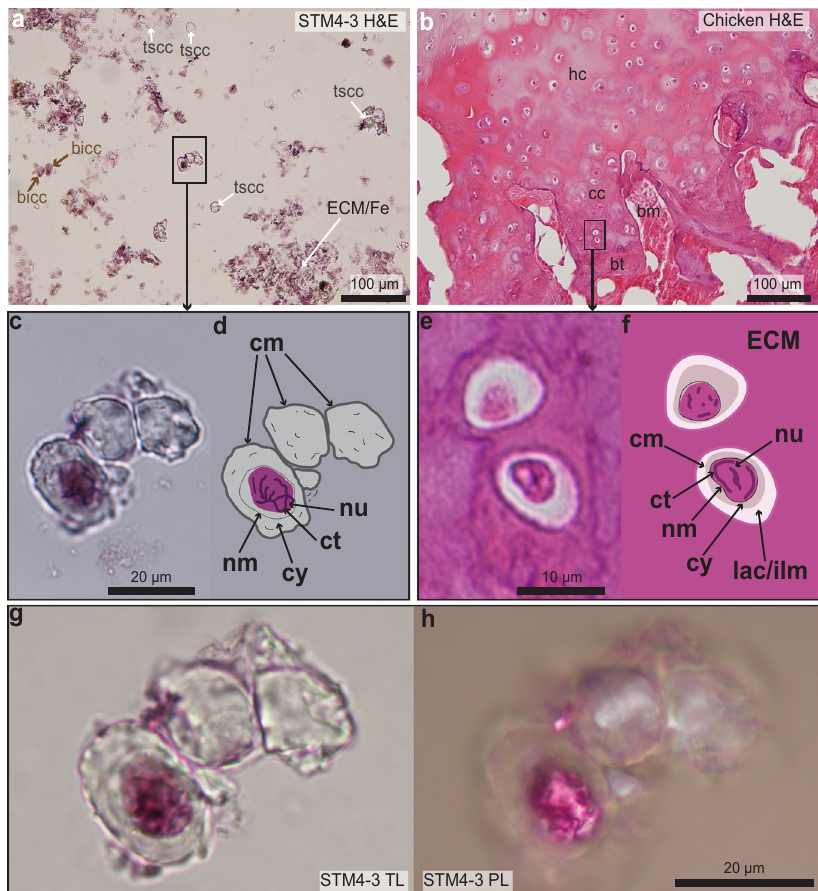
Fig. 4 Photographs of H&E stained paraf fi n sections of the cartilage of STM4-3 and that of an extant chicken. a A slide of STM4-3 cartilage (5 µ m thick) stained with H&E. Few extracellular matrix (ECM) and few chondrocytes are seen. b A slide of adult chicken cartilage (5 µ m thick) stained with the same method and shown at the same scale for comparison with Caudipteryx . c A close-up on three Caudipteryx cells shows one cartilage cell with stained intracellular structures and chromatin threads in dark purple. d Line drawing of ( c ) showing different fossilized cellular structures, like the unstained cytoplasm (cy), the unstained nuclear membrane (nm), and the stained nucleus (nu). e A close-up on two chicken cells. f Accompanying line drawing of ( e ) showing similar cellular structures sharing the same staining pattern as the Caudipteryx cell. Because the chicken cells are still within their ECM, their lacunae (lac) with potential intralacunar matrix (ilm) can be seen. g High-magni fi cation photograph (at ×100 with immersion oil) on the three Caudipteryx cells seen under transmitted light (TL). h Corresponding image taken under the polarized light (PL). Abbreviations: bicc, brown ironized cartilage cell; bm, bone marrow; bt, bone trabeculae; cc, calci fi ed cartilage; cm, cell membrane; ct, chromatin thread/chromocenter; ECM/Fe, extracellular matrix/Iron; hc, hyaline cartilage; tscc, transparent silici fi ed cartilage